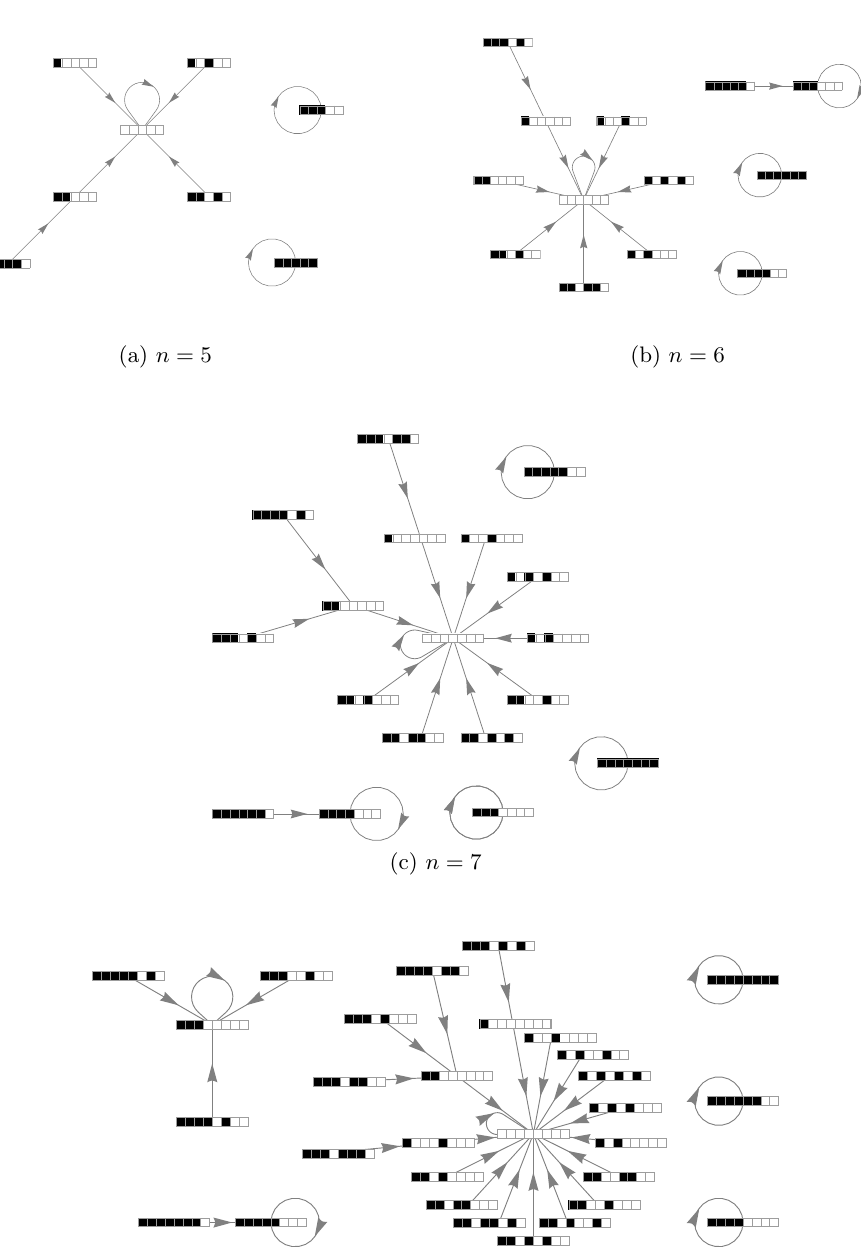
Figure 5: The state graph for the ESPD on a cycle of order n a + b 2 ≤